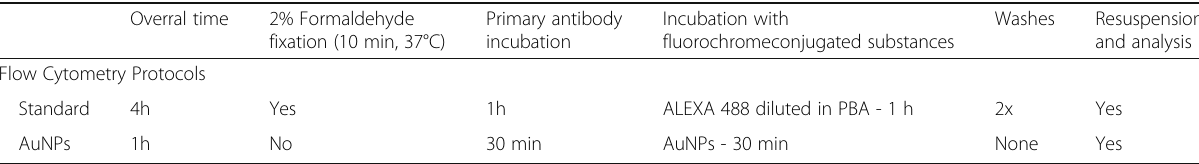
Table 2 Comparison of flow cytometry protocols based on ALEXA and AuNPs Overral